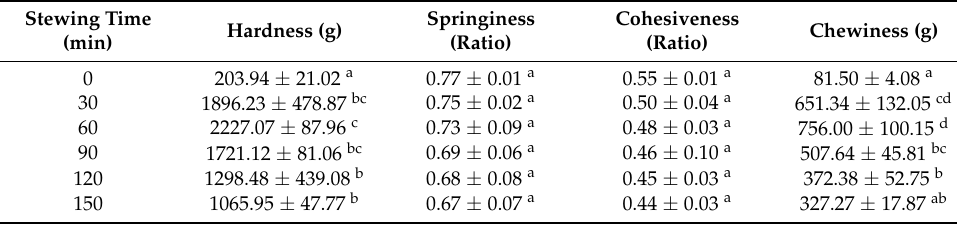
Table 1. Effects of stewing time on texture properties of Sichuan-style braised beef. Stewing Time Hardness (g) (min)